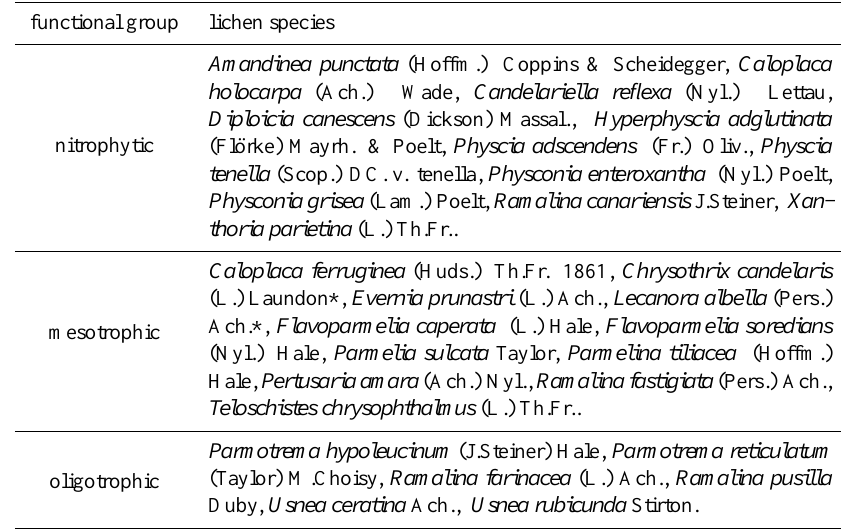
Table 1. Lichens species classification into functional response groups regarding eutrophication tolerance, based on Nimis and Martellos, 2008. The maxima of the original “species indicator values” were taken and species with a maximum value of 1 or 2 were considered oligotrophic, species with a maximmum classification of 3 were considered mesotrophic, species with a maximum classificaiton of 4 or 5 were considered